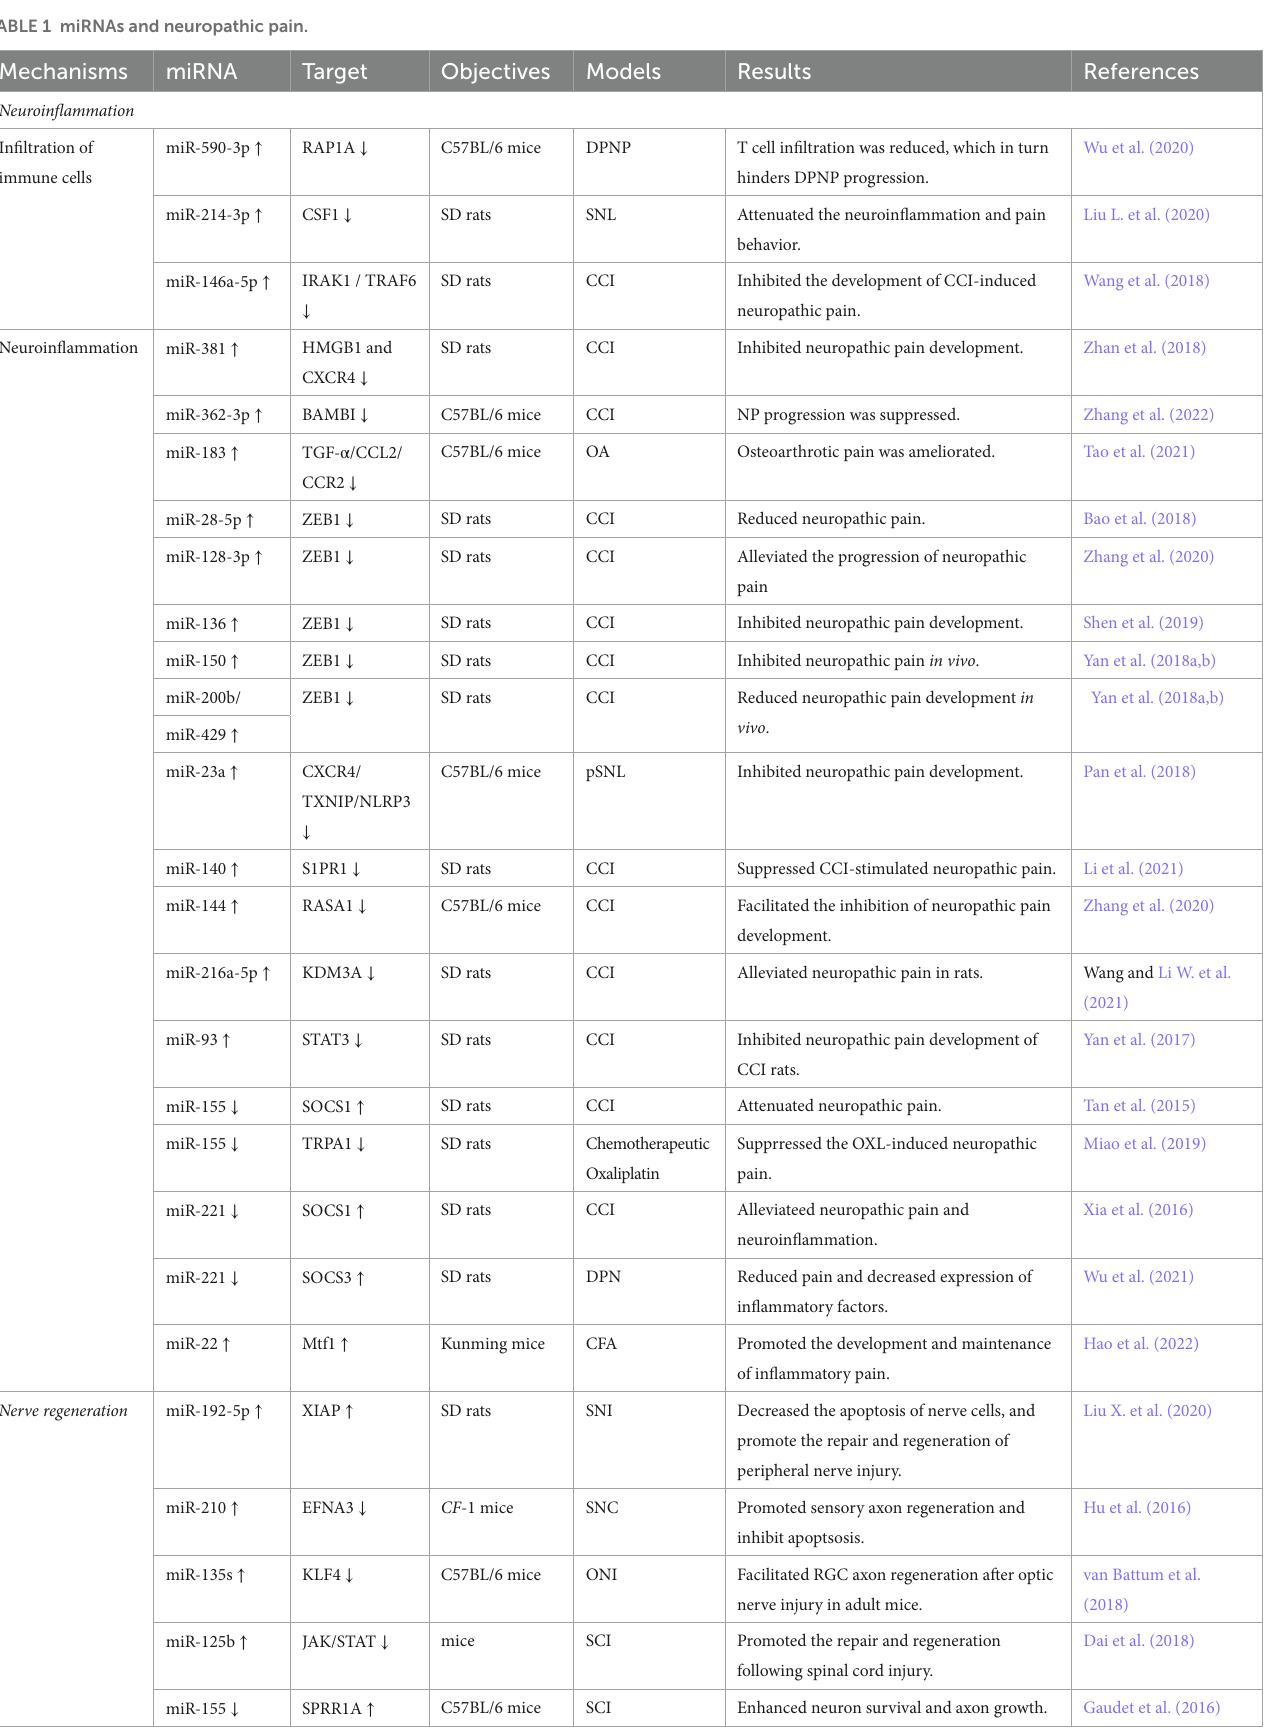
TABLE 1 miRNAs and neuropathic pain. Mechanisms